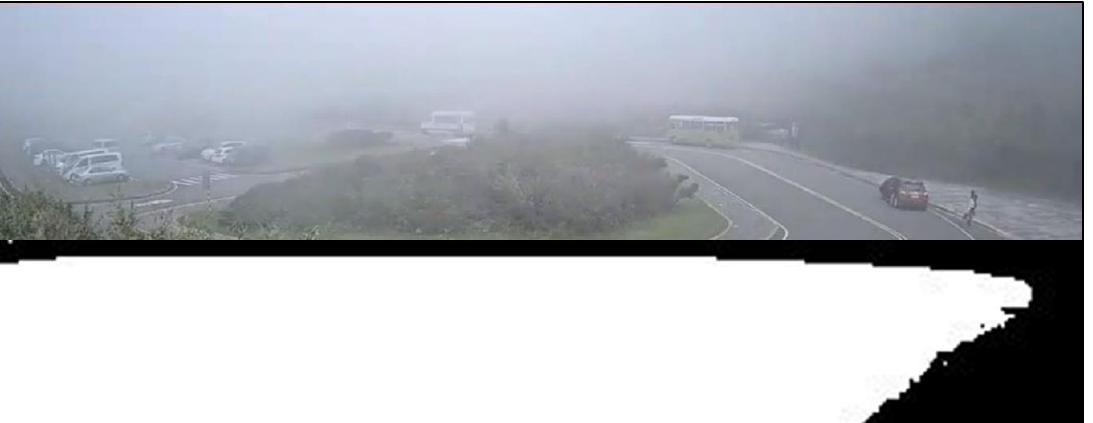
Figure 3. Contrast property assessment result.